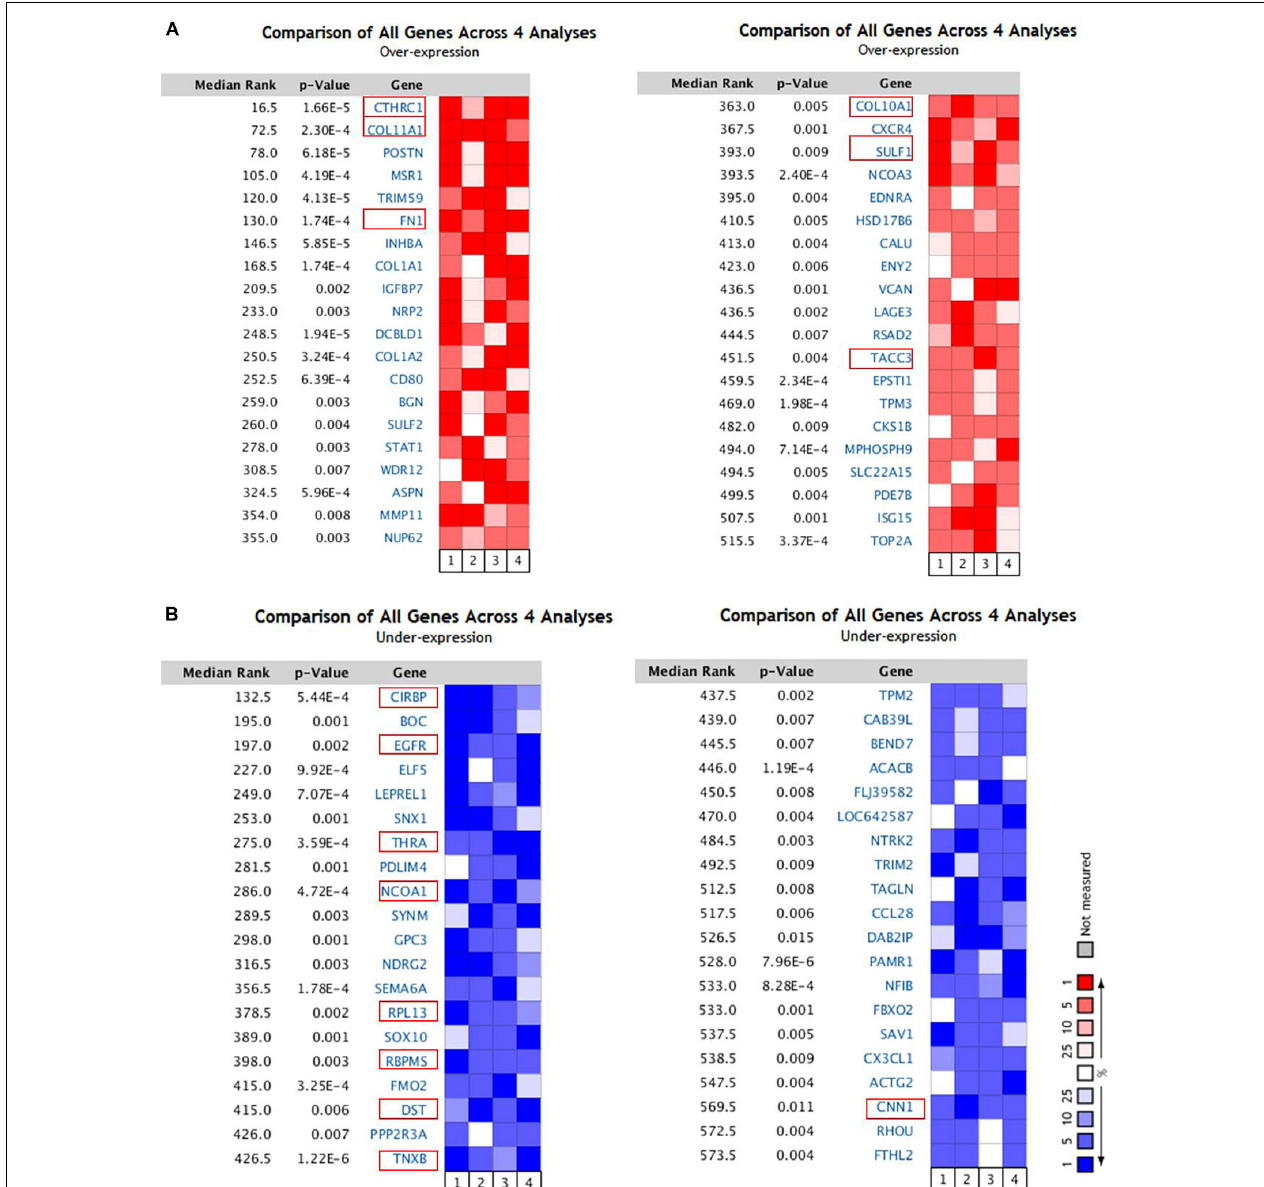
FIGURE 1 | The 80 genes that were significantly dysregulated in breast cancer according to four independent microarrays retrieved from the Oncomine database. (A) The top 40 genes upregulated in microarrays. (B) The top 40 genes downregulated in microarrays.